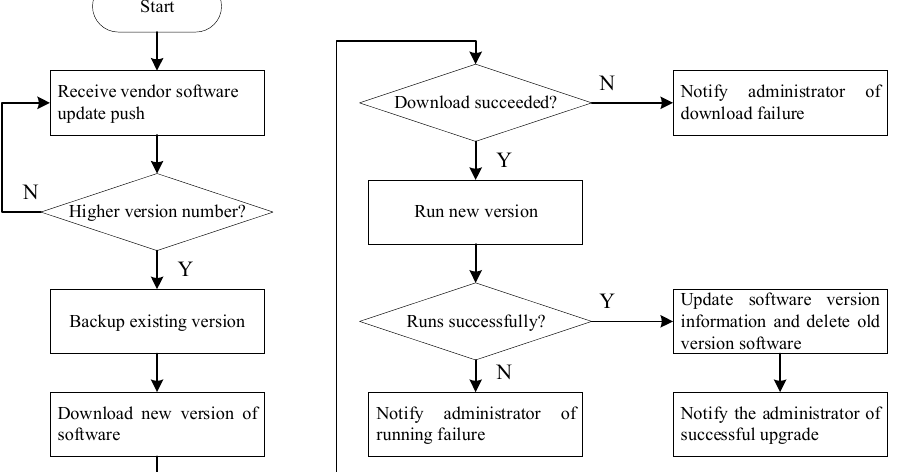
Figure 10. The software upgrade process.